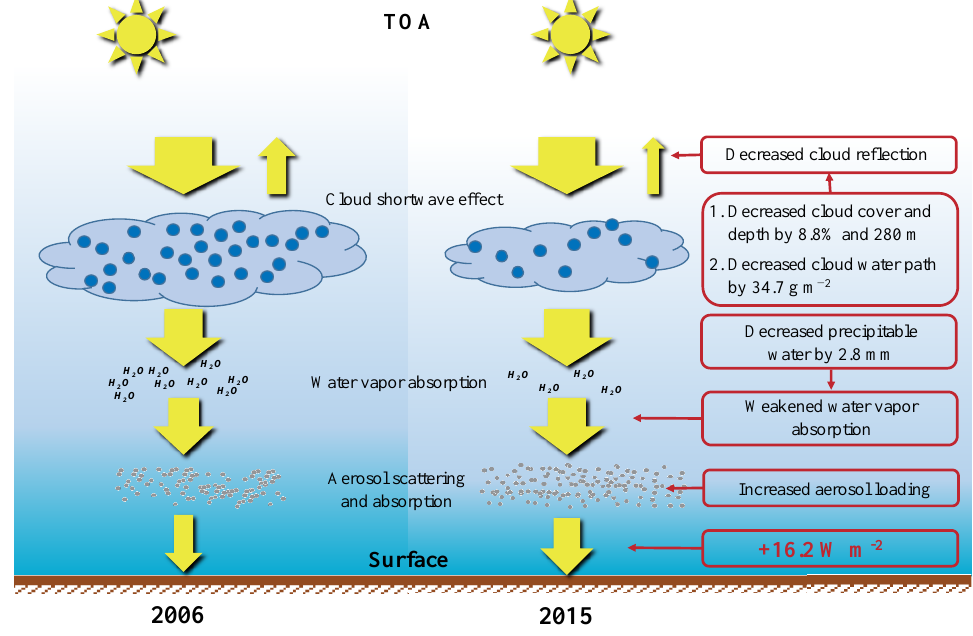
Figure 10. Schematic of the impacts of 3D aerosol, cloud, and water vapor variations on brightening during the monsoon season in South Asia from 2006 to 2015. Background gradient color represents the changing RH. The relative humidity is high when the color is dark.